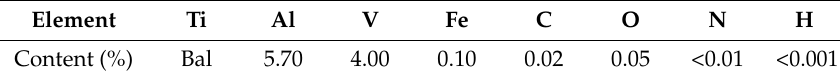
Table 1. Chemical composition of the Ti6Al4V titanium